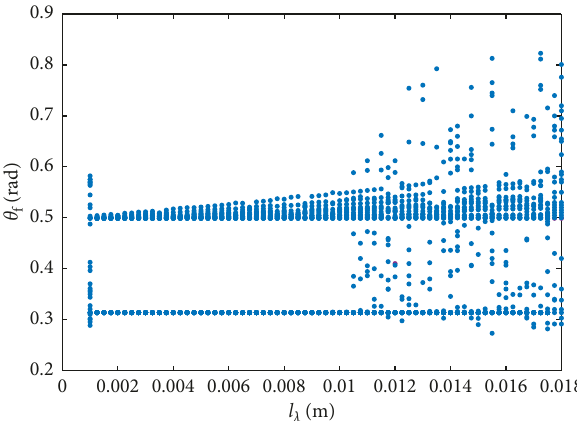
Figure 4: Global bifurcation diagram of θ